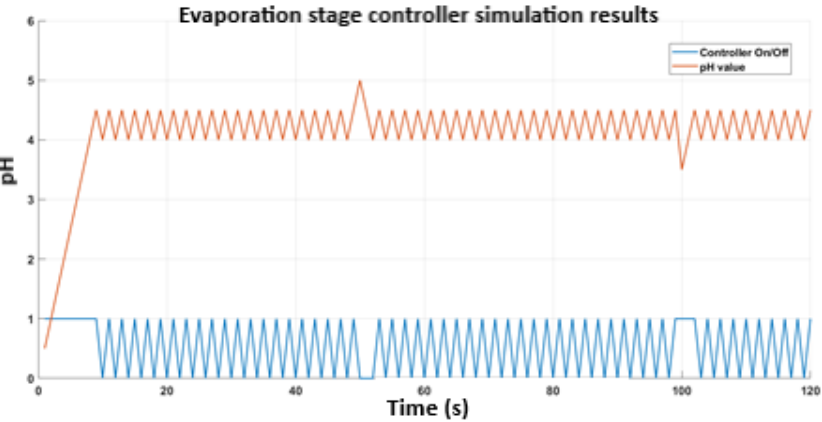
Figure 8. Simulation results of the pH controller of the evaporation stage.